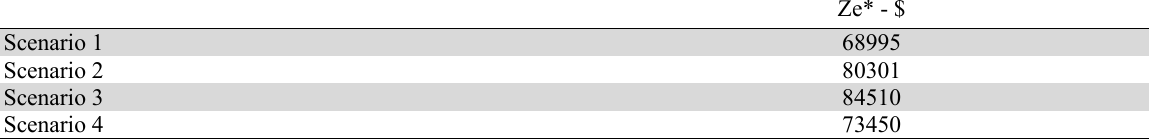
Values of the objective functions for four